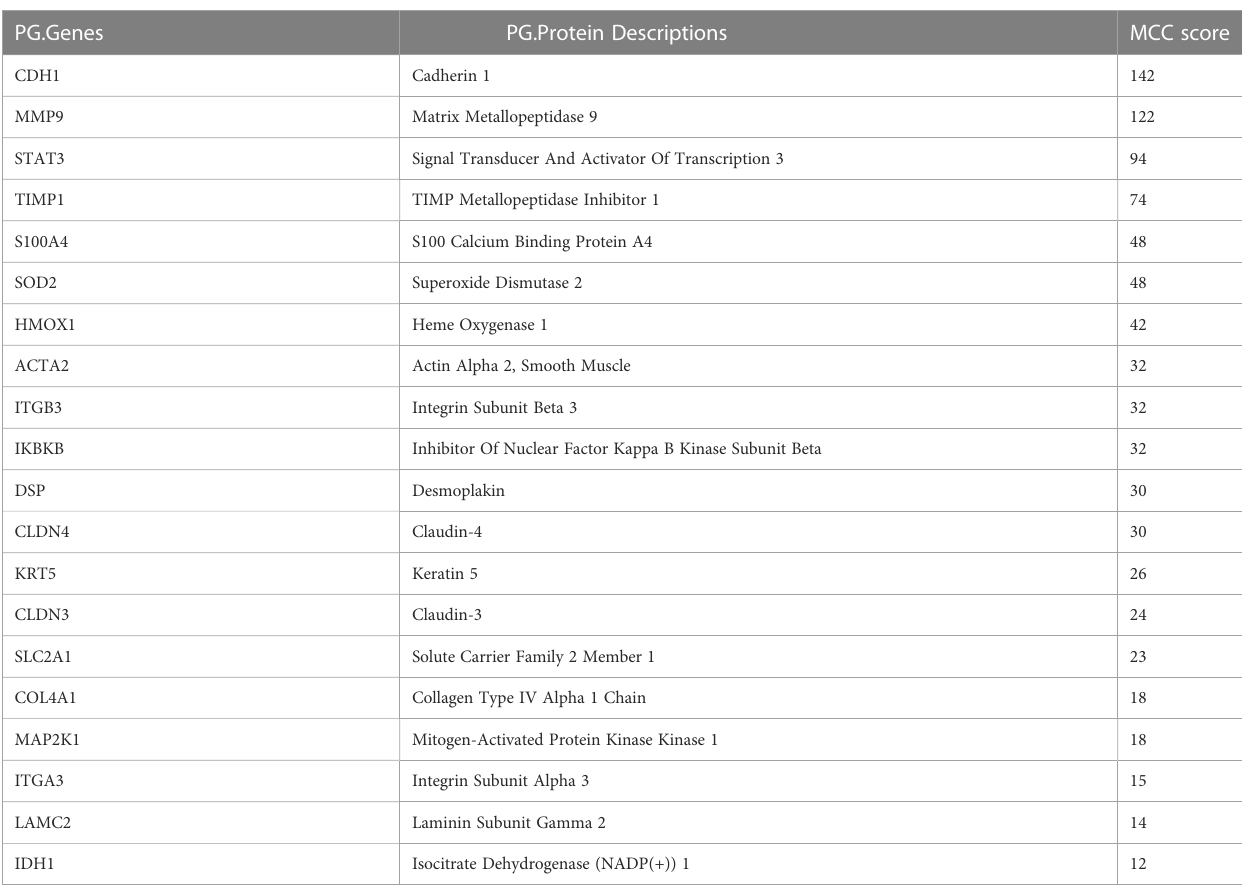
TABLE 1 Top 20 hub EMT-related DEPs ranked by MCC score.